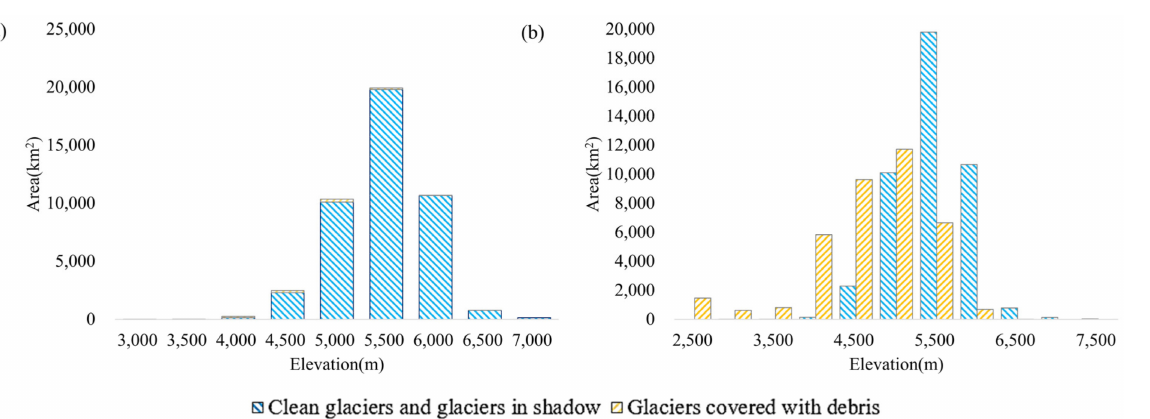
Figure 13. Elevation distribution of glaciers: ( a ) the elevation distribution of all glaciers; ( b ) the elevation distribution of clean glaciers, glaciers in shadow, and debris-covered